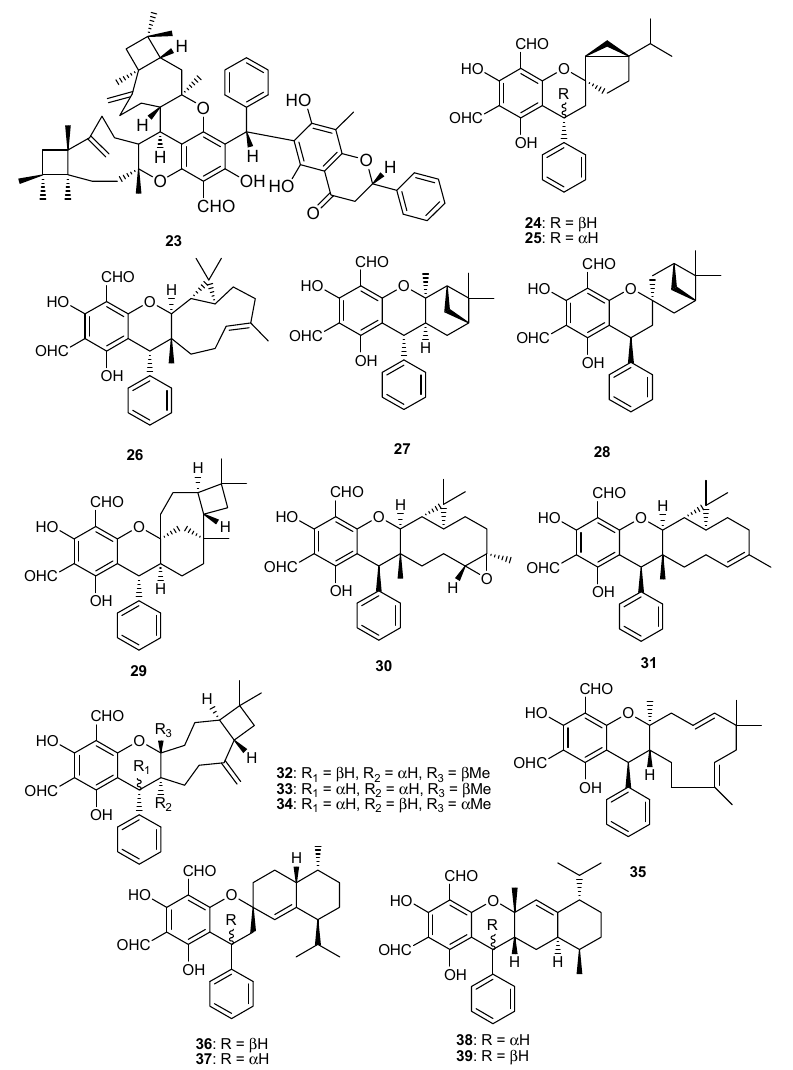
Figure 4. Meroterpenoids isolated from P. guajava L. Psiguadiols A–J ( 64–73 ), meroterpenoids were isolated from leaves of the P. guajava L., which has 6,8-diformyl-5,7-dihydroxy-4-phenylchromane-coupled sesquiterpenoids along with a C-8-spiro-fused 6/6/9/4 tetracyclic ring system. The chemical structure of the natural product was determined from spectroscopic data, ECD data, and single-crystal X-ray diffraction data. The protein tyrosine phosphatase 1B (PTP1B) is critically involved in insulin receptor signaling and an important target from treatment of DM type II. Inter- estingly guava meroterpenoids, psiguadiols A, G, H ( 64 , 70 & 71 ) inhibited PTP1B with IC 50 values of 4.7, 6.2 and 9.2 µ M respectively [53], while all other compounds were found inactive. Three psiguamers A–C ( 74 – 76 ) sesquiterpene-based meroterpenoids bearing a rare methylated benzoylphloroglucinol and bicyclogermacrene units, were isolated from leaves of P. guajava L. Their structures were established through comprehensive analysis of spectroscopic data, electronic circular dichroism (ECD) and X-ray crystallographic data. All compounds were tested for anticancer activity but only compound (+)- 74 showed strong cy- totoxic activities against five human tumor cell lines; HCT-116, HepG2, BGC-823, A549, and U251 with values of IC 50 ; 2.94, 9.01, 6.45, 5.42 and 5.33 µ mol/L respectively [54]. Seventeen meroterpenoids were isolated from the leaves of the Psidium guajava including euglobal B1-1 ( 77 ), euglobal Ib ( 78 ), euglobal Ic ( 79 ), euglobal III ( 80 ), euglobal IIb ( 81 ), euglobal-Iva ( 82 ), euglobal Ivb ( 83 ), euglobal V ( 84 ), macrocarpal A ( 85 ), ecalrobusone E ( 86 ),